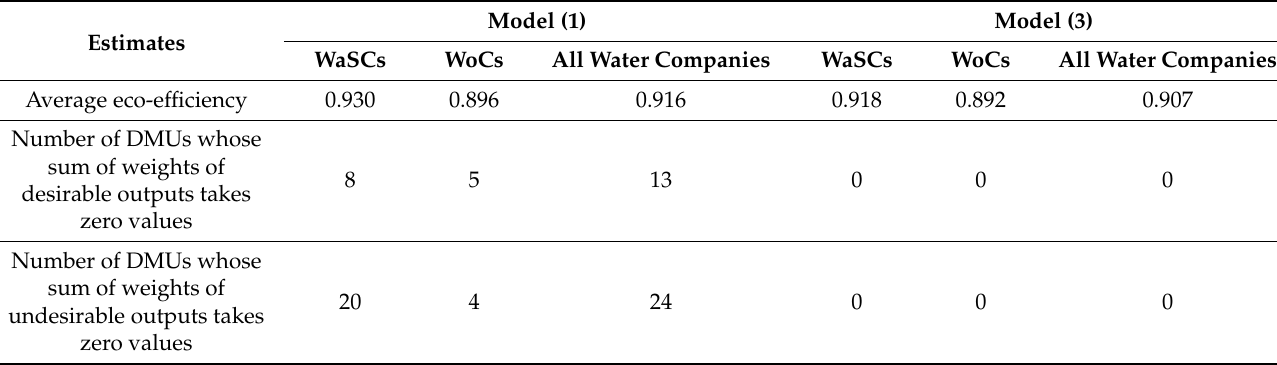
Table 2. Summary of pooled statistics of eco-efficiency